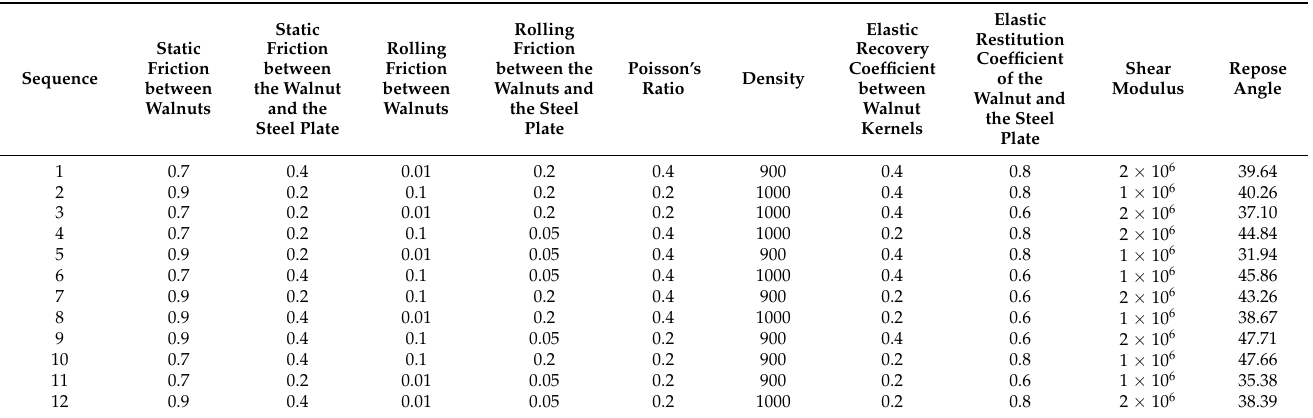
Table 4. The simulated results of the two-level